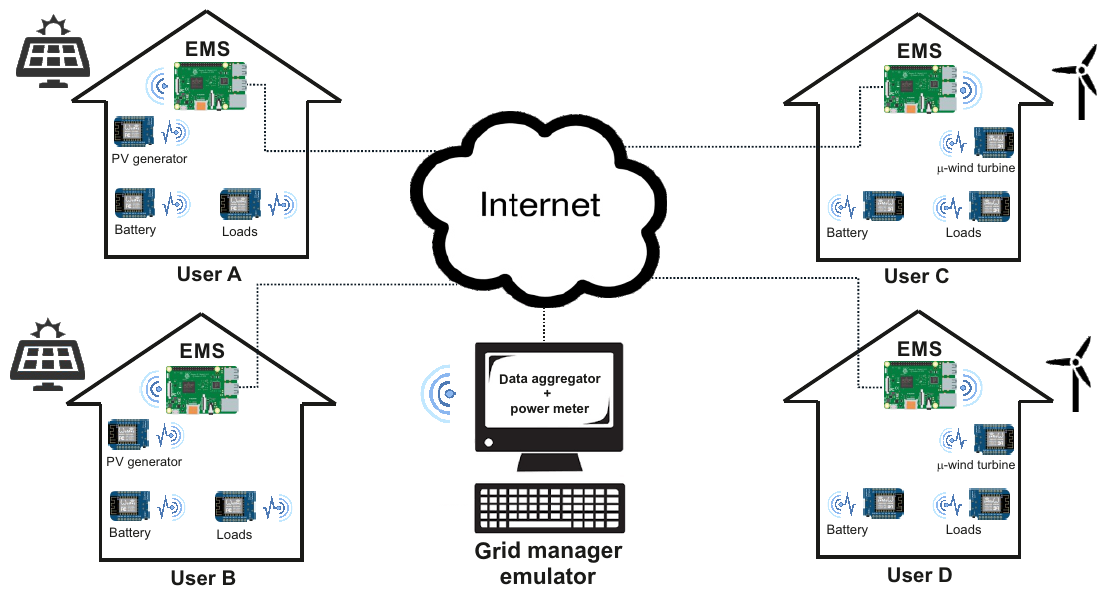
Figure 4. Synopsis of the experimental